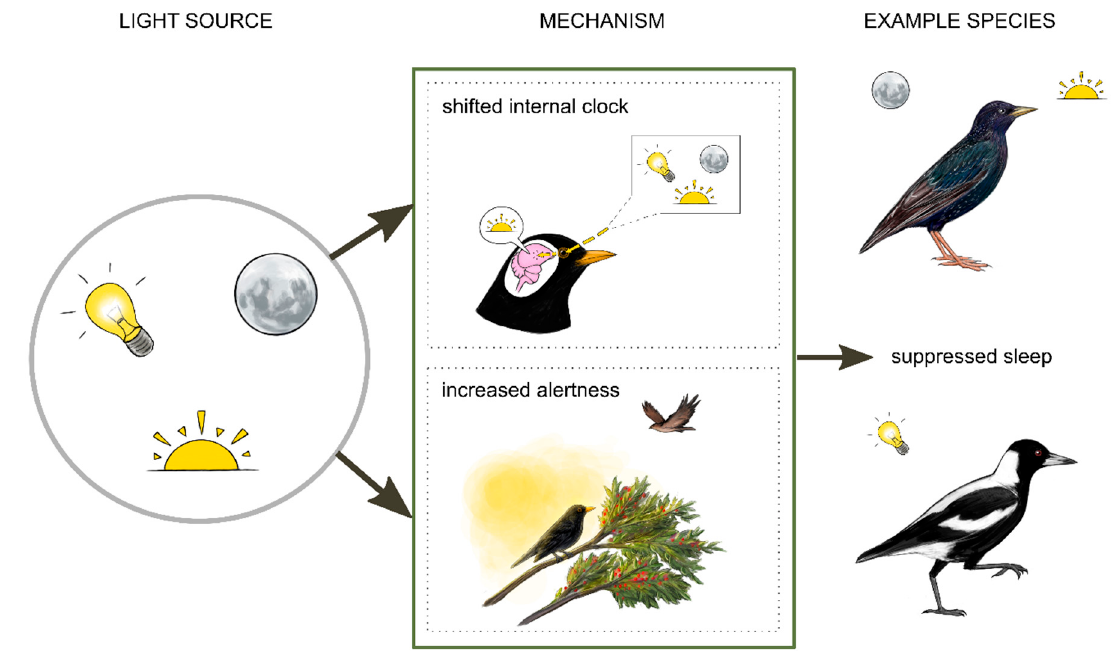
Figure 2. Exposure to light can suppress sleep in birds. European starlings sleep less in summer and during a full moon [53]. Australian magpies show disrupted sleep under artificial light at night [54]. There are two broad mechanisms by which these effects might occur. Light might influence sleep indirectly by shifting the timing of the circadian clock. In European blackbirds, increased activity at night during light exposure has been linked to reduced melatonin, a hormone important for regulating circadian timing [55]. Light might also directly increase alertness by masking natural light cues and facilitating foraging or vigilance [51]. Illustrations by Laura X. Tan.